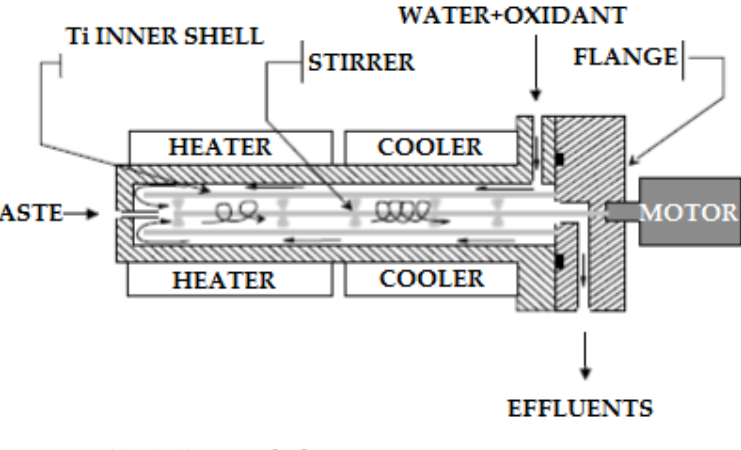
Figure 15. Double shell reactor [68].